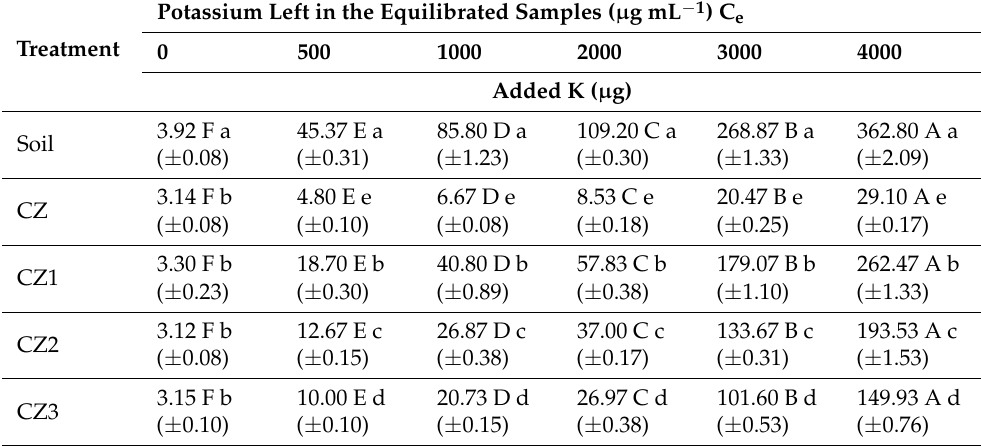
Table 6. Interactive effects of the different potassium concentrations and treatments (Soil only, clinop- tilolite zeolite only, and soil with different amounts of clinoptilolite zeolite) on potassium content.